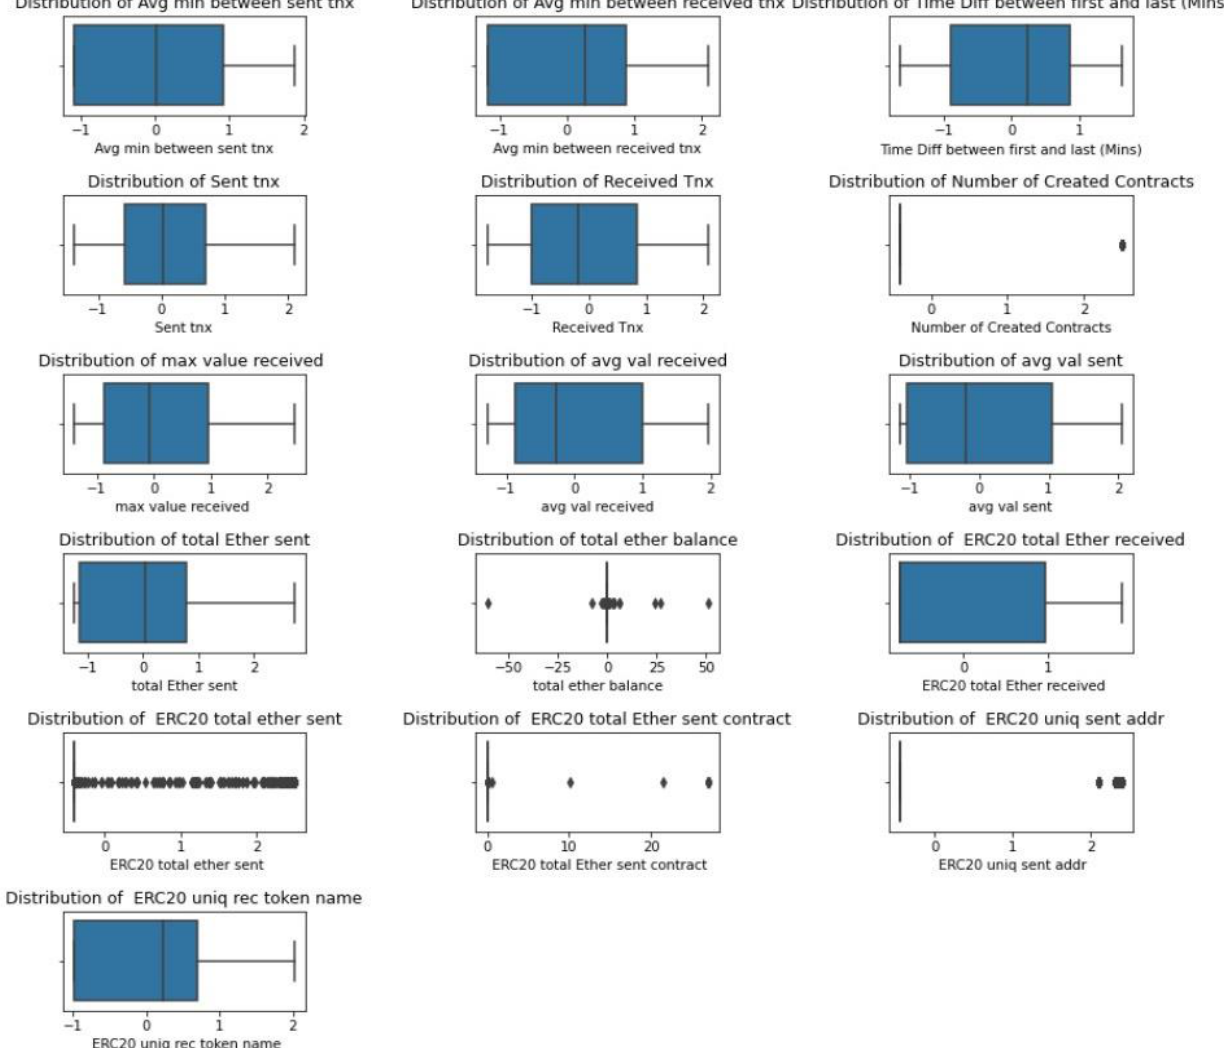
Figure 5. Boxplots depicting the distribution of features post log transformation.